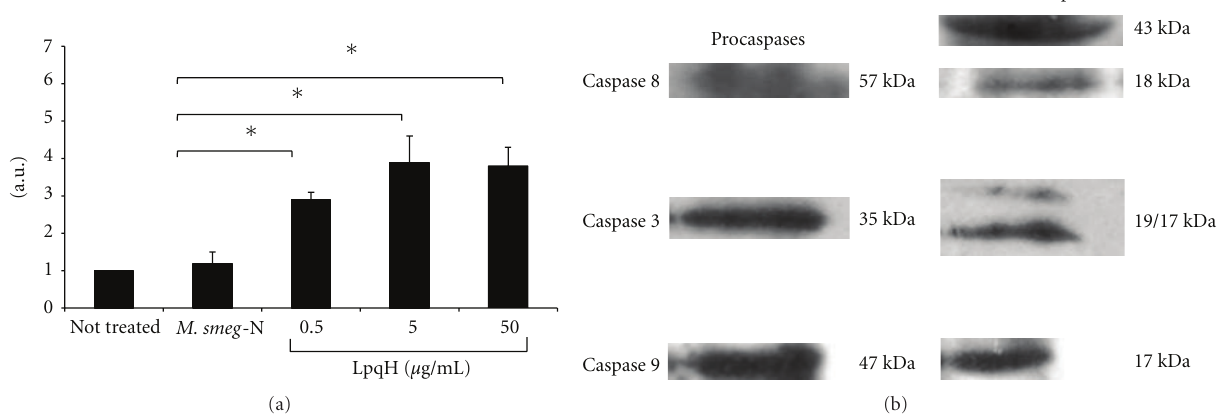
Figure 1: Mycobacterium tuberculosis LpqH lipoprotein induces caspase-dependent macrophage apoptosis. (a) Peripheral blood monocyte- derived human macrophages were incubated for 1h with LpqH. As a control, cells were incubated with 100 μ g protein present in 19-kDa nitrocellulose strips of native M. smegmatis ( M. smeg-N ), which as seen by immunoblot do not contain LpqH (not shown). Apoptosis was measured with a nucleosome ELISA kit. Apoptosis is expressed as the mean ± SE arbitrary units (a.u.)of four independent experiments. Statistically significant di ff erences are indicated; ∗ P < 0 . 05. (b) To determine the role of caspases, whole-cell protein extracts of MO made apoptotic by incubation with 5 μ g LpqH were separated by SDS-PAGE and immunoblot analysis was performed with antibodies to caspases 8, 3, and 9. Procaspases and cleaved caspases are shown.